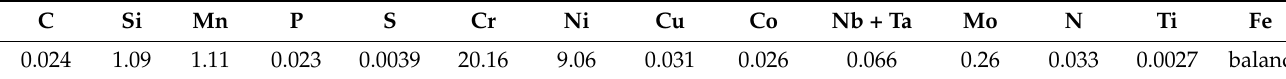
Table 1. Chemical composition of the Z3CN20.09M cast austenite stainless steel (wt%).